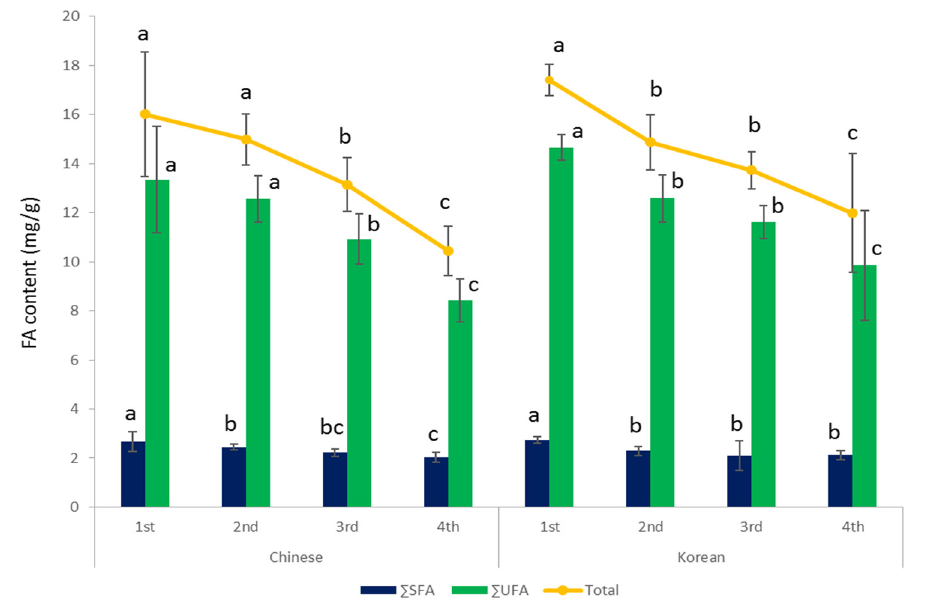
Figure 5. Comparison of FA compositions and levels in shiitake mushrooms cultivated using Chinese or Korean substrates based on the harvesting cycle. Σ UFA: sum of UFAs, Σ SFA: sum of SFAs, Total: total amount of FAs measured in mushrooms. a–c Values with different superscripts differ significantly with respect to the harvesting cycles of shiitake produced by each substrate. Table 1. Fatty acid (FA) compositions and levels in shiitake mushrooms based on the harvesting cycle and cultivation substrate origin (mg ∙ g − 1 dry weight basis).